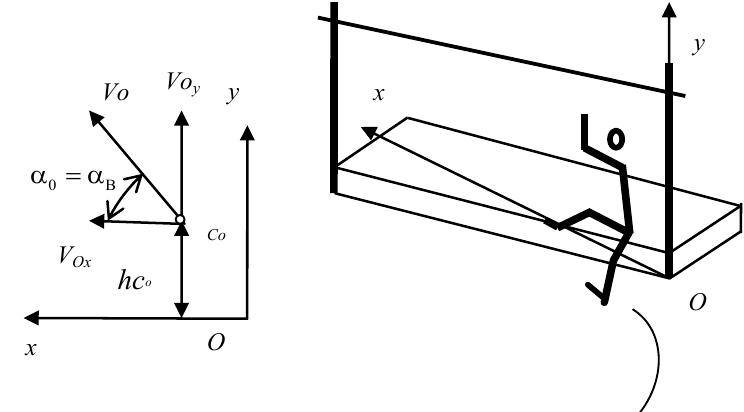
Fig.1. Calculated diagram for determination of repulsion